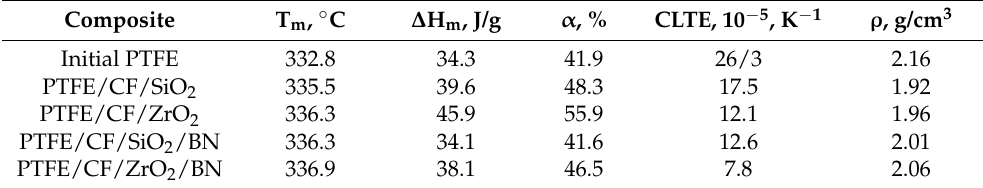
Table 2. Thermodynamic properties and density of the initial PTFE and